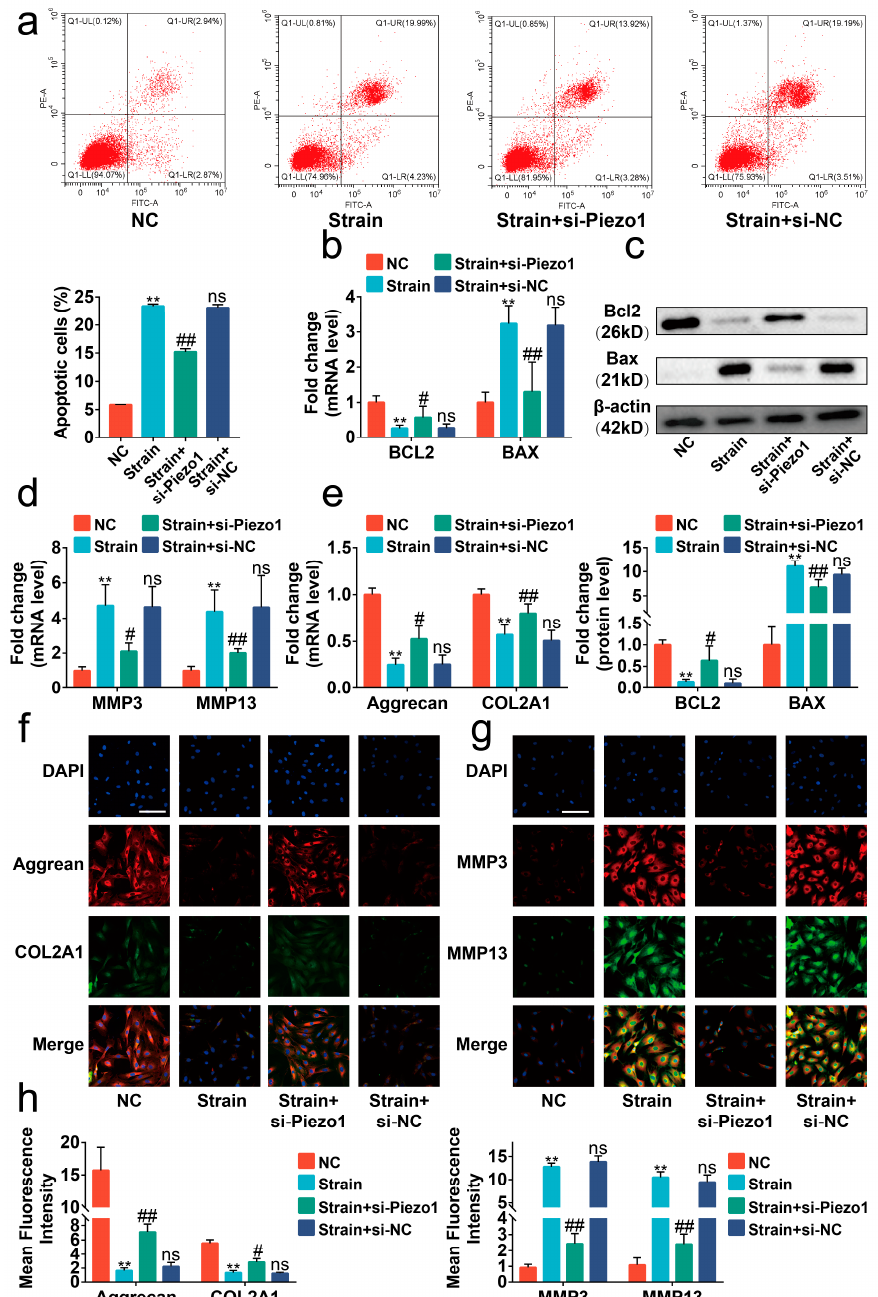
Figure 2. Mechanical strain induced the apoptosis and anabolic/catabolic imbalance in chondrocytes through Piezo1. ( a ) Flow cytometry analysis of chondrocyte stained with Annexin V-FITC and PI ( n = 3). ( b ) The mRNA levels of BAX and BCL2 in chondrocytes were determined by RT-qPCR ( n = 3). ( c ) Western blot analysis of BAX and BCL2 in chondrocytes ( n = 3). ( d , e ) The mRNA level of MMP3, MMP13, Aggrecan, and COL2A1 in chondrocytes quantified by RT-qPCR ( n = 3). ( f , g ) Immunofluorescence staining of MMP3, MMP13, Aggrecan, and COL2A1 in chondrocytes ( n = 3). ( h ) Quantified results of immunofluorescence. ** p < 0.01 vs. NC; # p < 0.05 vs. strain; ## p < 0.01 vs. strain; ns, no significant differences. One-way ANOVA with Bonferroni’s test for ( a – e , h ), Kruskal–Wallis test with Dunn’s multiple comparisons test for Aggrecan in ( d ). Scale bar: 100 μ m.